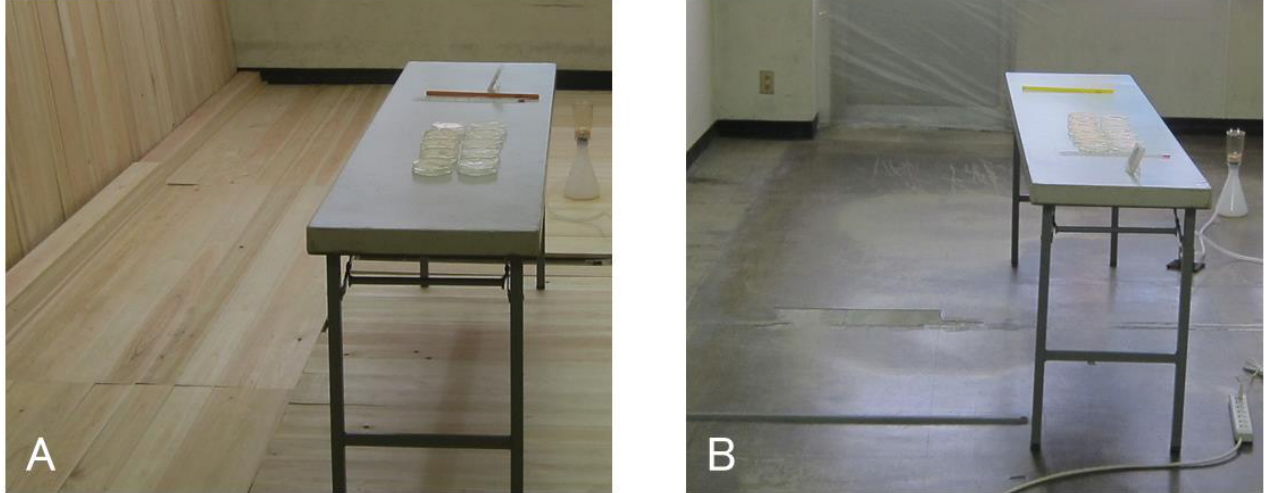
Figure 1. The appearance of the two rooms where the experiments were conducted. These two rooms were adjacent on the first floor of Owase City Hall, Japan. ( A ) a room containing timbers from Hinoki cypress on the floor and walls (experimental group); ( B ) a room without Hinoki cypress material (control group).